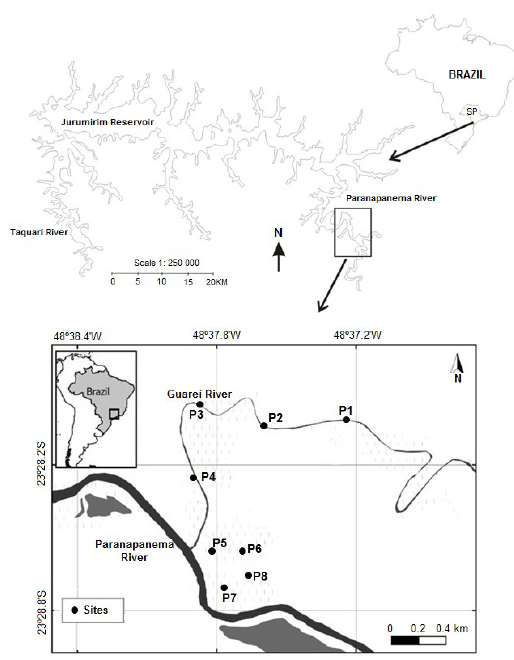
Figure 1. The study area in the mouth zone of the Guareí River into the Paranapanema River (São Paulo, Brazil) (1 to 4, and 5 to 8: sampling sites along the Guareí River and in the lateral area,